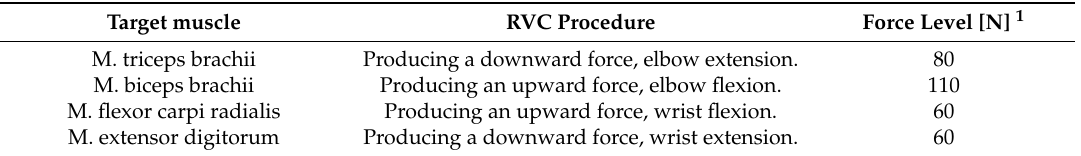
Table 2. Descriptions of submaximal reference voluntary contractions (RVC) of the four target muscles, with corresponding force levels at which subjects had to sustain the RVC.